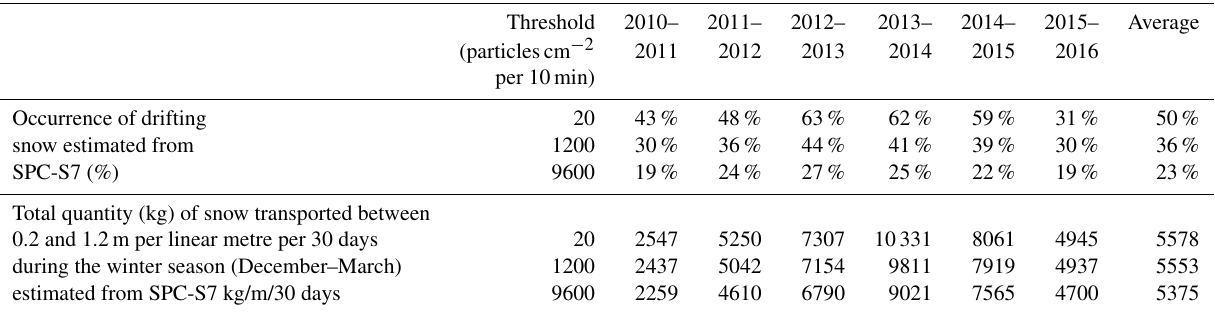
Figure 4. Percentage of time when snow particles are detected by SPC-S7 for each winter (1 December to 31 March) during the period 2010–2016 at the Col du Lac Blanc experimental site and the corresponding quantity of snow transported between 0.2 and 1.2m per linear metre. Due to missing or invalid SPC-S7 data, the length of the time series varies from a winter season to another winter season, making it difficult to study the interannual variability of blowing snow intensity. To overcome this, an average quantity of snow transported between 0.2 and 1.2m per linear metre during 30 days has been calculated. Numbers in brackets indicate the percentage of valid data delivered by the SPC-S7 during the considered winter season: it provides a confidence index for the data. Table 2. Occurrence of drifting snow and total quantity of snow transported between 0.2 and 1.2m per linear metre per 30 days for different threshold